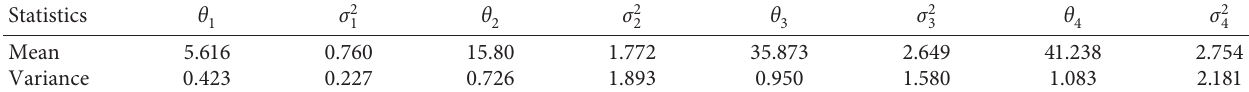
Table 3: The mean and variance of prior sample parameters.